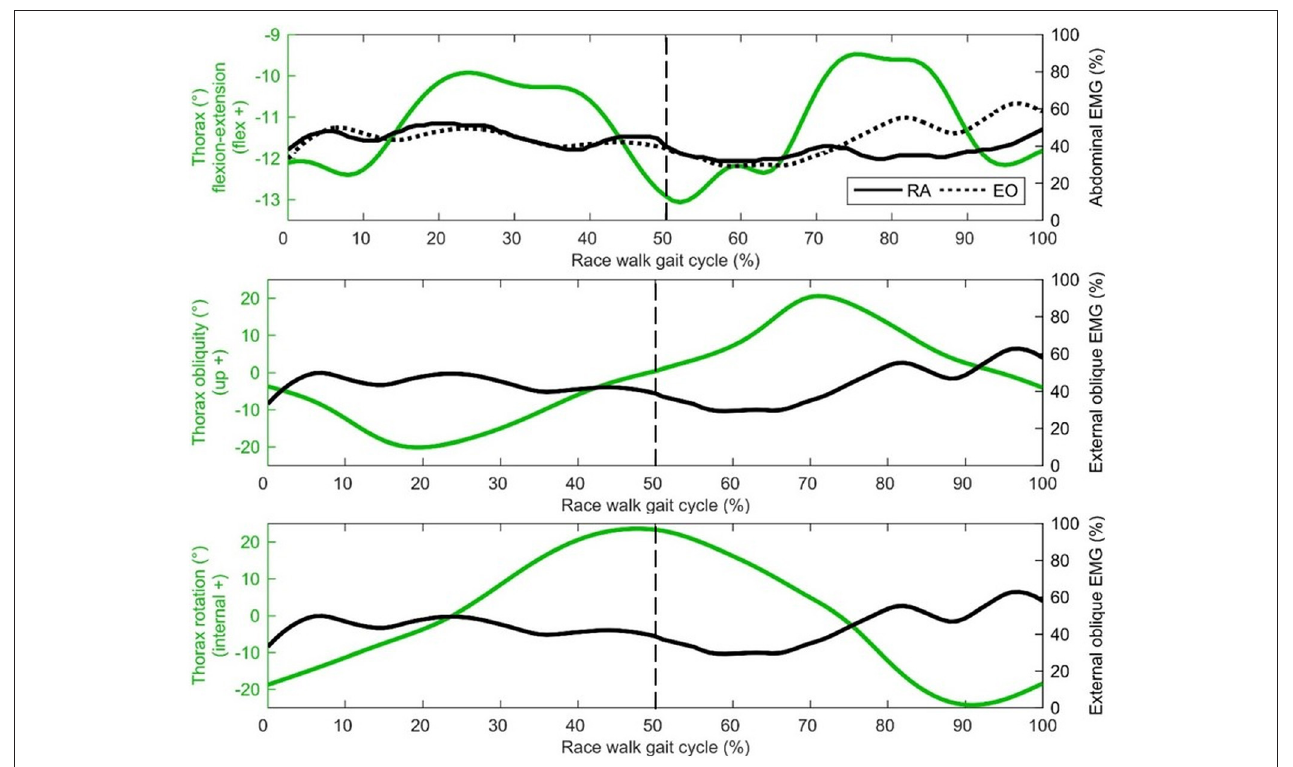
FIGURE 5 | Thorax group mean joint angle kinematics (green) presented with EMG activity (black) on the secondary axis [rectus abdominis (RA), external oblique (EO dotted)]. The dashed vertical line represents gait cycle division between stance (from 0 to 50%) and swing (from 50 to